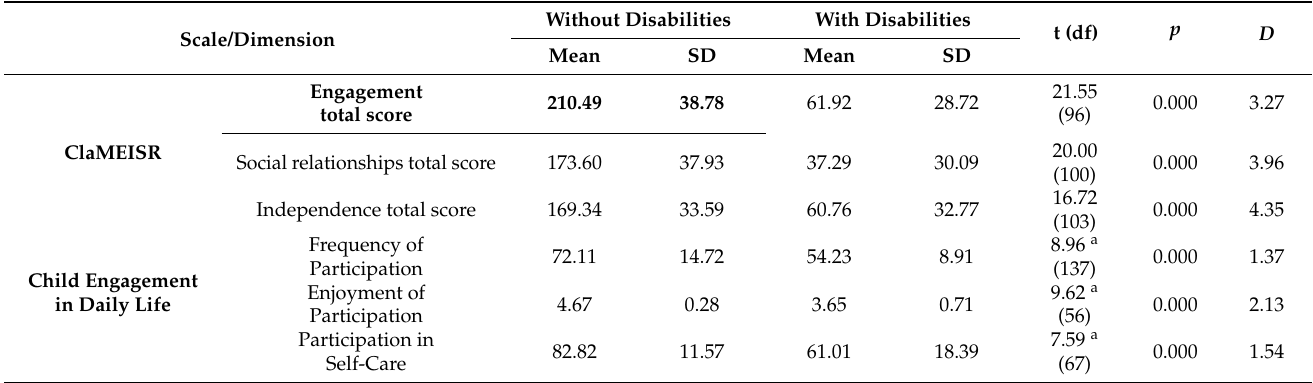
Table 4. Differences in the ClaMEISR and CEDL subscales between children without disabilities and with